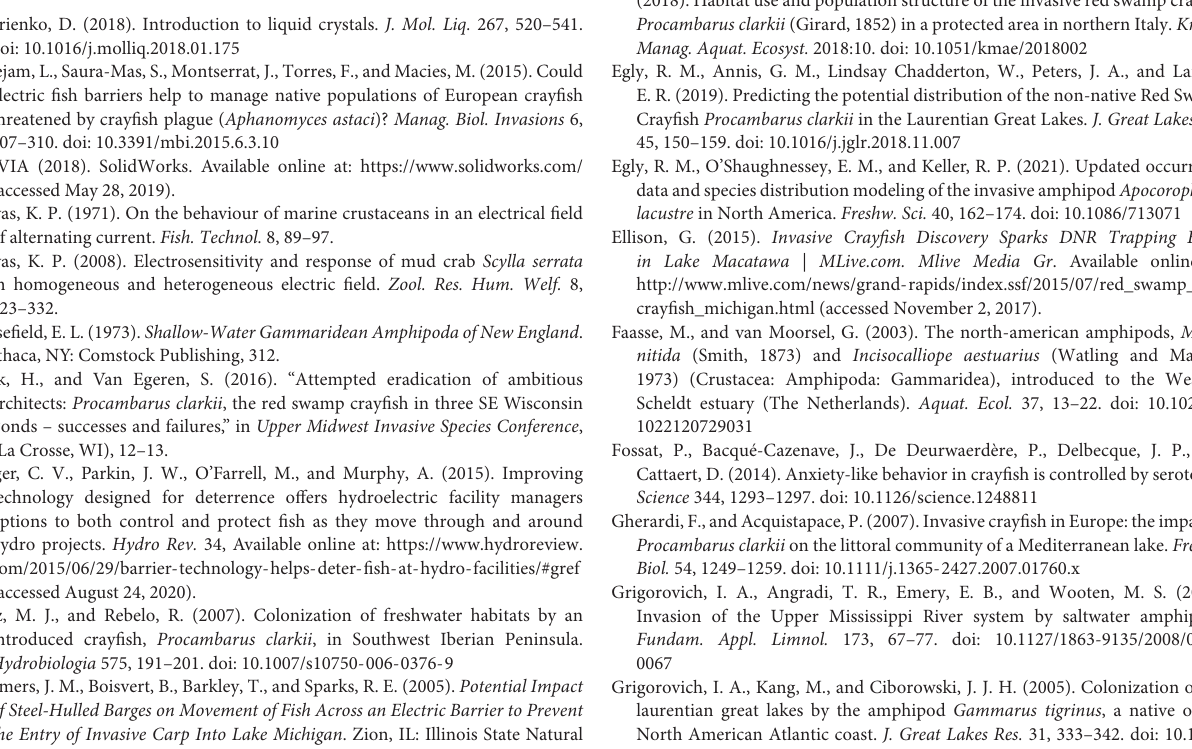
Supplementary Figure 1 | Behavior of juvenile Procambarus clarkii during stimulus (barrier on) and post-stimulus (barrier off) phases for (A) 25%, (B) 50%,